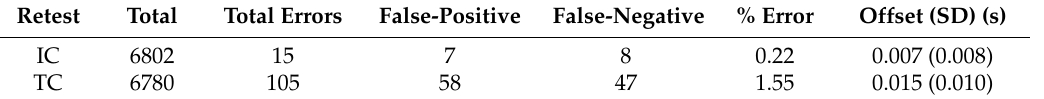
Table 4. Event-detection results for the retest. The total of detected events, number of erroneous detections, false positives and false negatives, percentage error and the offset between OMC and IMU system plus SD are shown.